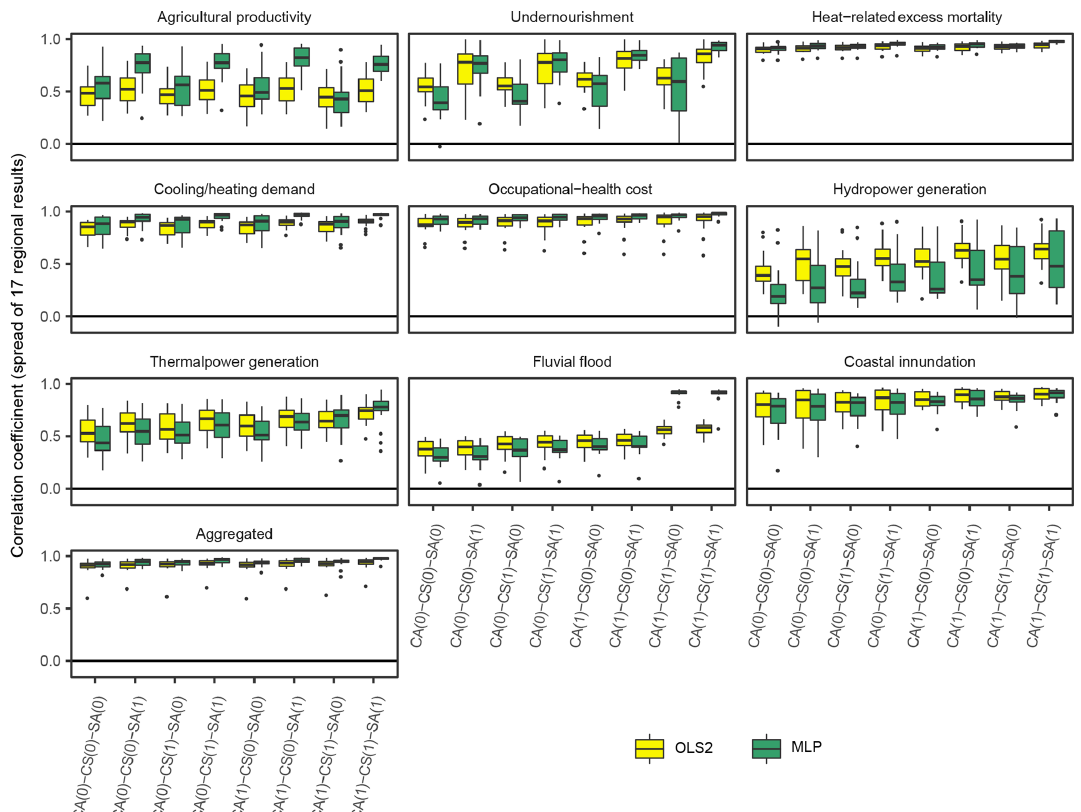
Figure 4. Performance of emulations in comparison 3. Correlation coefficients between simulation results and emulation results are shown. CA(1) denotes that climate variables for all regions (including non-target region) are used. CS(1) denotes that seasonal climate variables are used. SA(1) denotes that socioeconomic variables for all regions (including non-target region) are